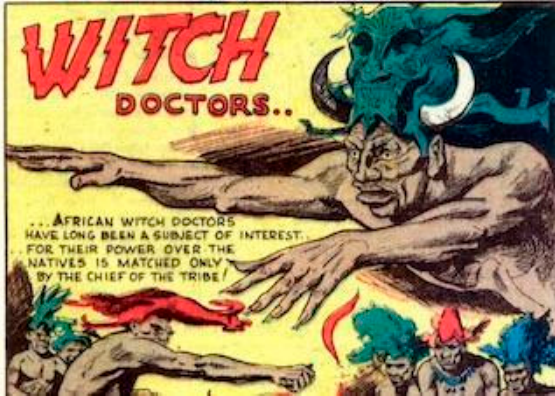
Figure 4. African Witch Doctors. Spellbound , 1954.